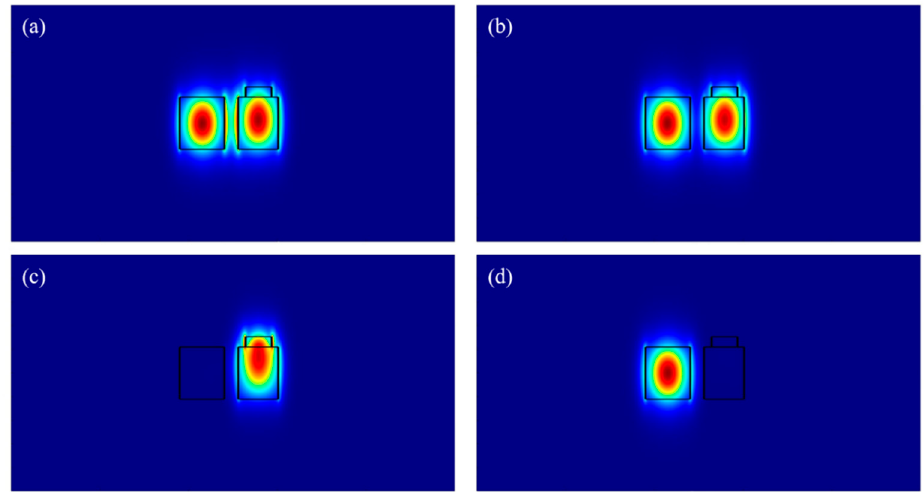
Figure 5. Intensity profiles of ( a ) even and ( b ) odd supermodes in the DC coupler waveguides when GSST is in the amorphous state; ( c , d ) show the mode distribution in DC coupler waveguides when GSST is in the crystalline state.